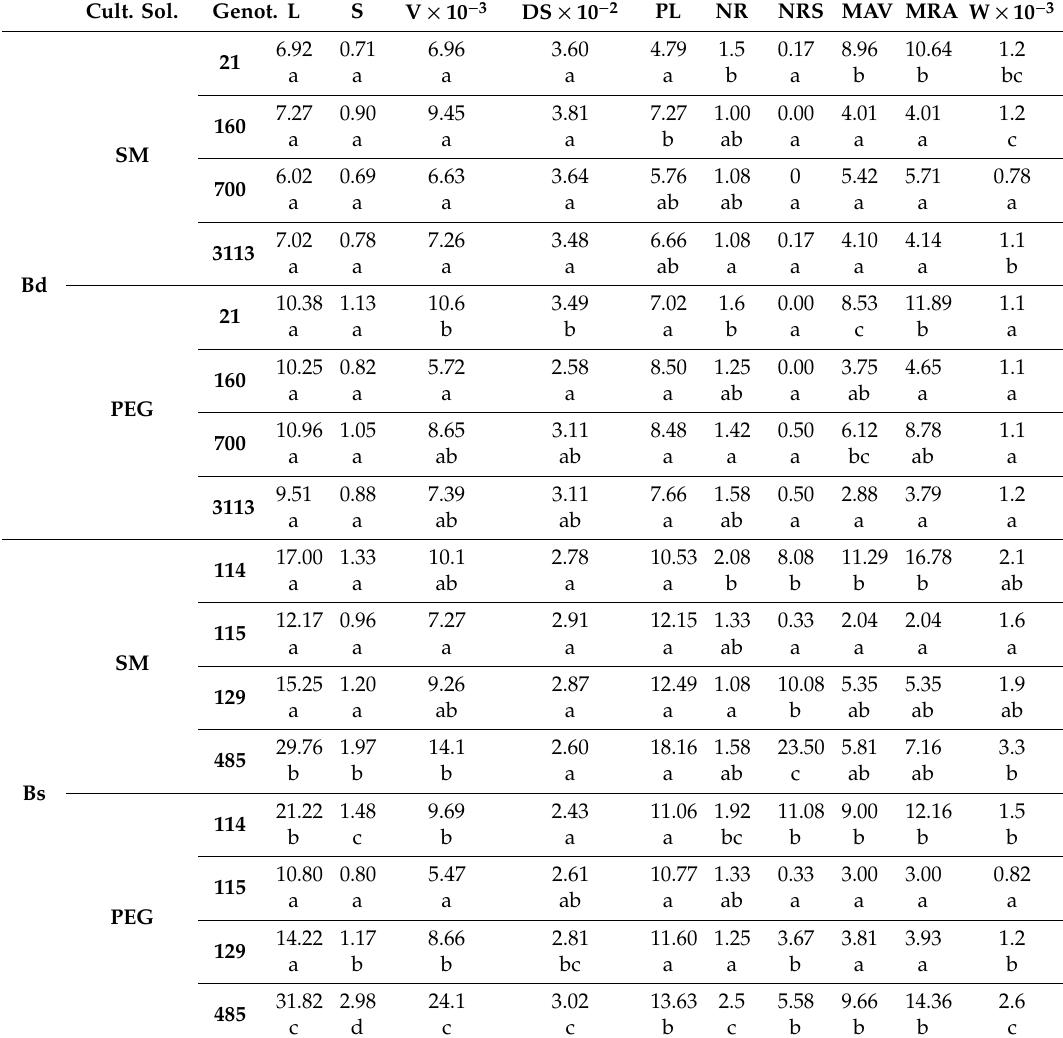
Table 3. Means of the RSA variables and W respect to the genotype of Brachypodium species, in each culture media. Di ff erent letters indicate statistical significance at p < 0.05 level of probability. Cult.